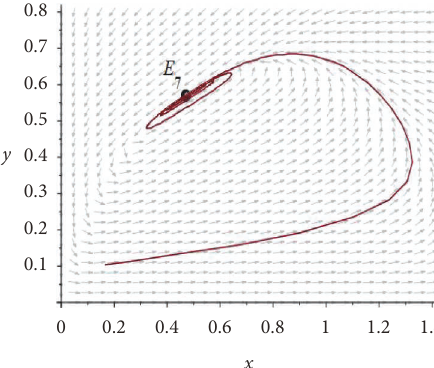
Figure 6: A codimension 3 Bogdanov-Takens singularity (focus type) in the case ( C